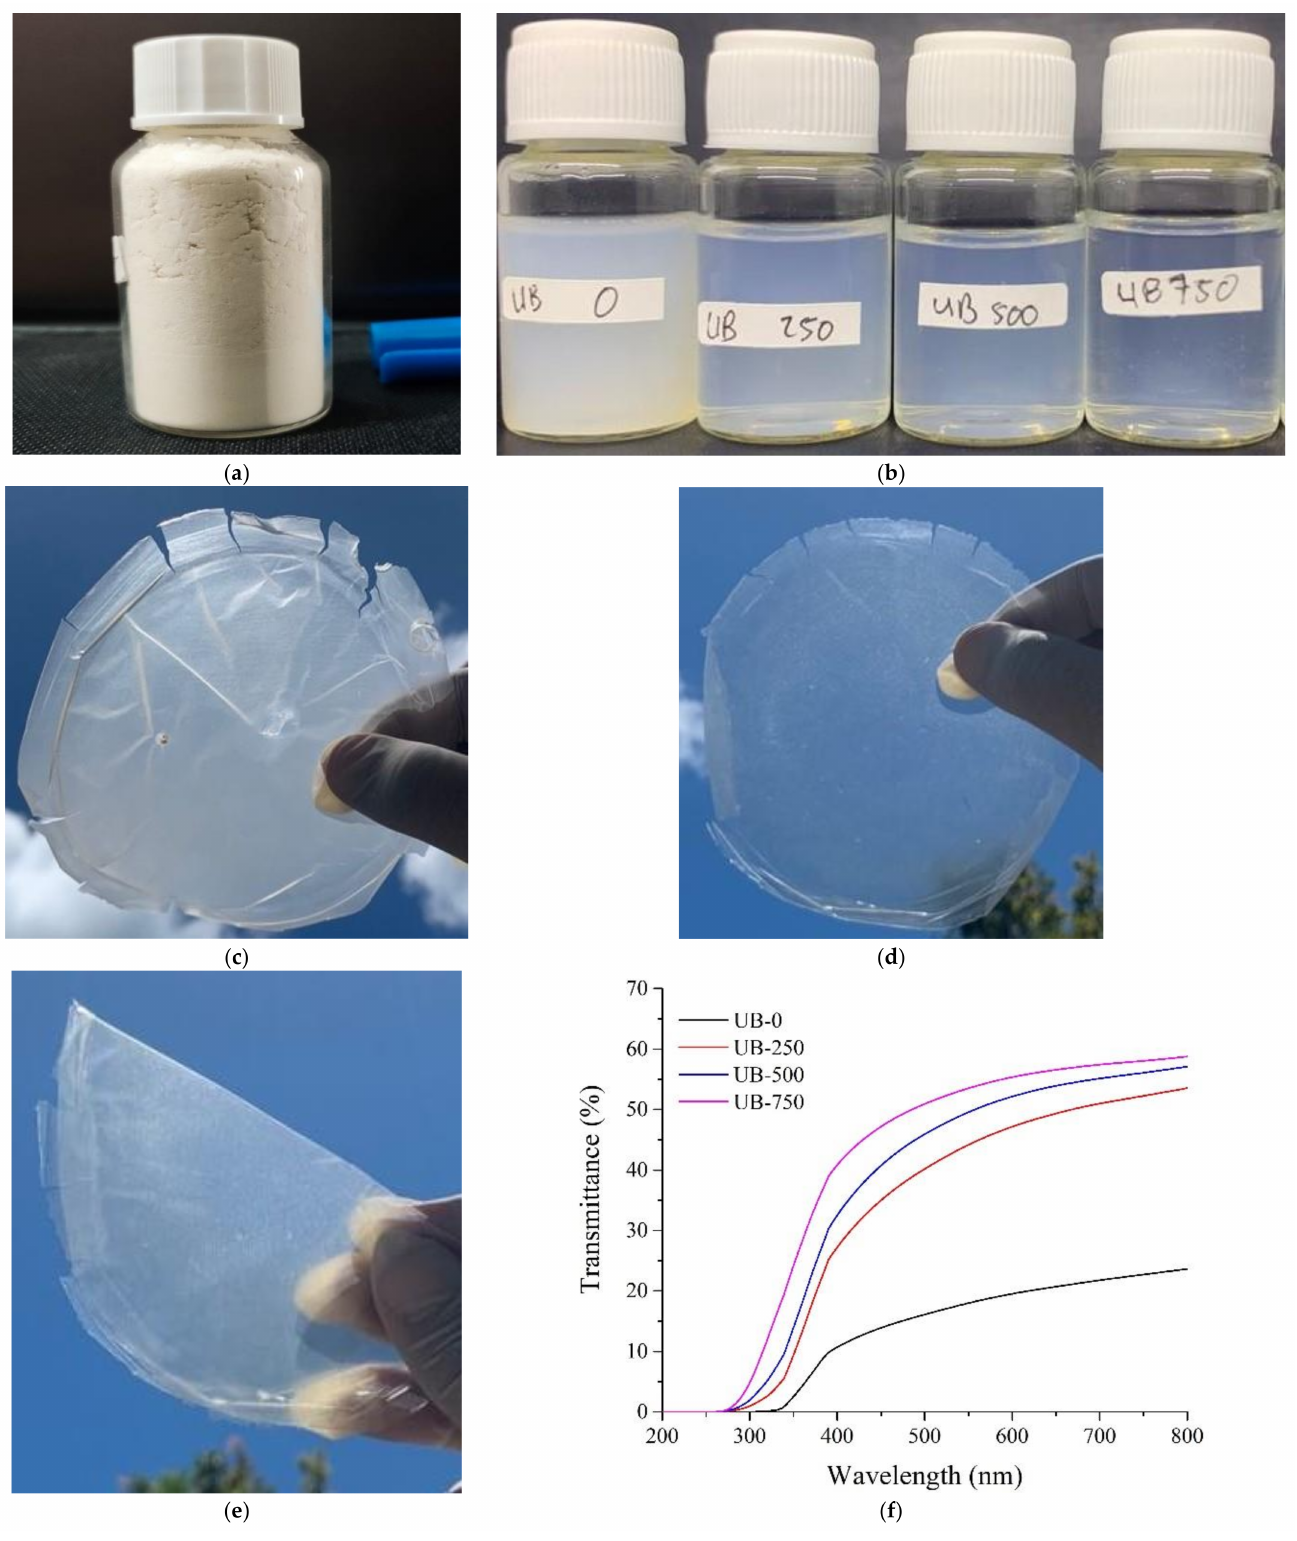
Figure 1. ( a ) BC powder, ( b ) appearance of treated BC suspension from various ultrasound energy, ( c ) translucent UB-0 film, ( d ) transparent UB-750 film, ( e ) bendable UB-750 film, ( f ) transmittance value of